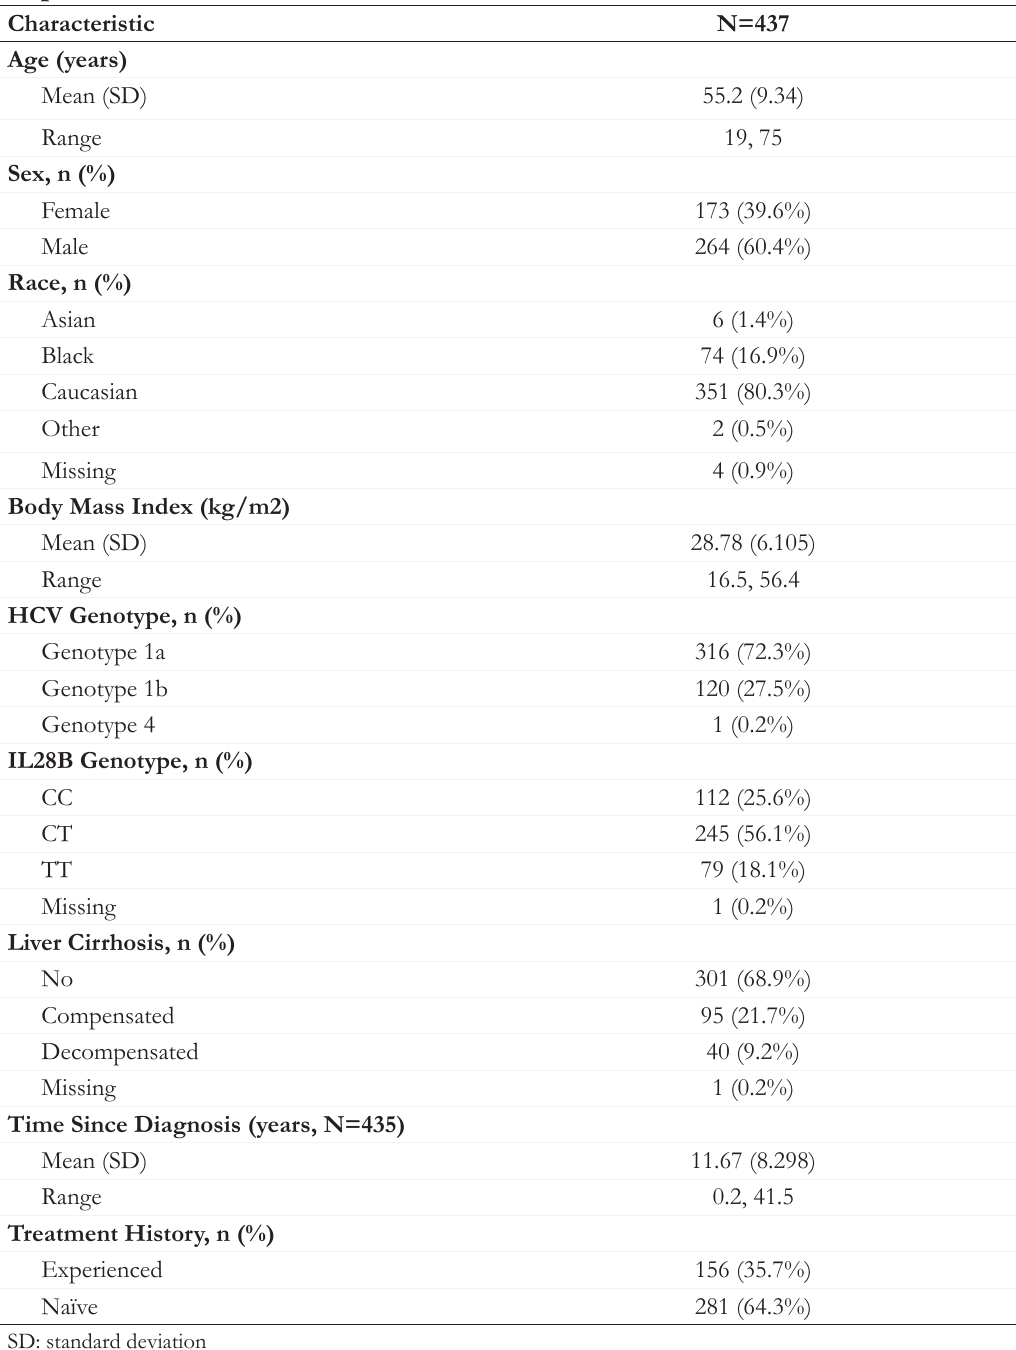
Table 3. Demographic and Clinical Characteristics for Overall Pooled Population at